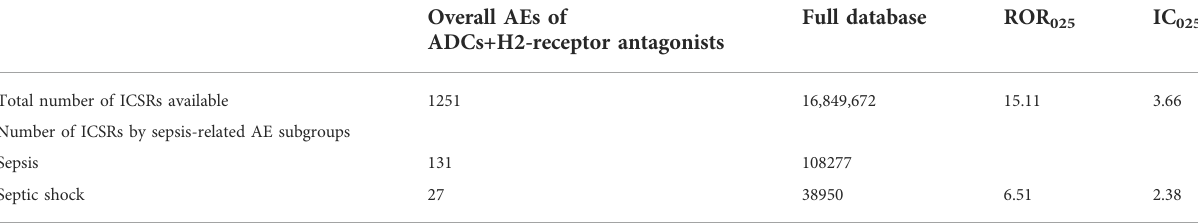
TABLE 7 Sepsis safety signals for ADC and H2-receptor antagonists combination therapy.